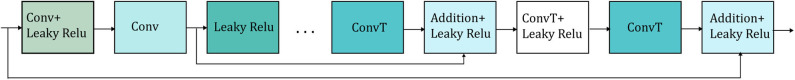
Detailed illustration of the way that the skip connections (represented by the arrows) are applied in the network. Only two skip connections are shown for simplicity. Conv stands for convolution and ConvT for transposed convolution.